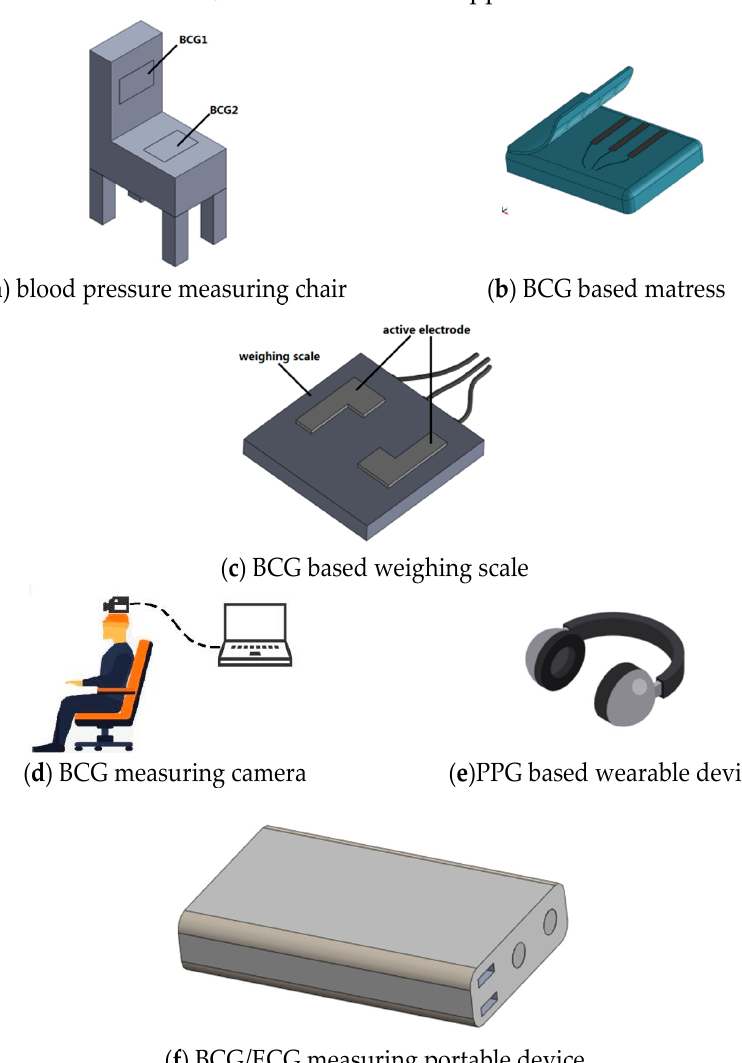
Figure 3. Various devices for BCG/SCG measurement.